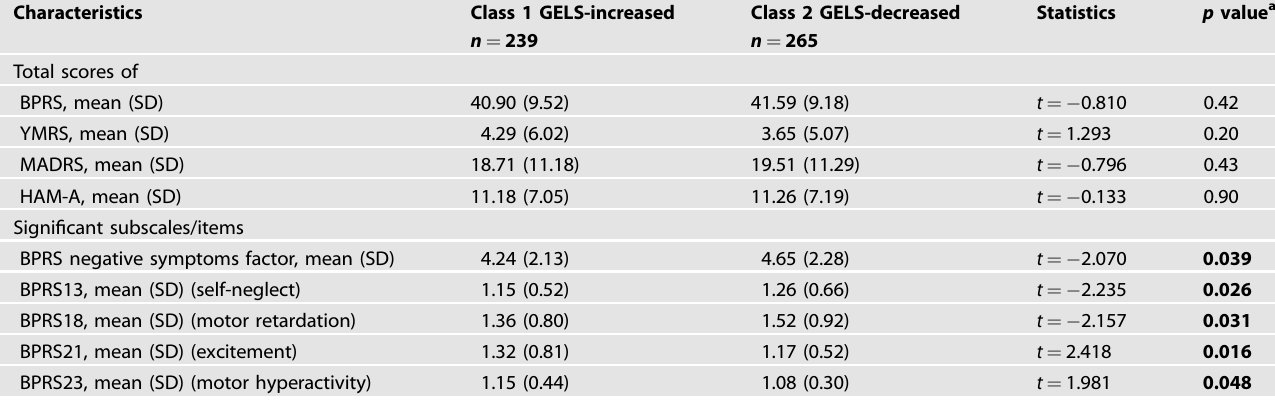
Table 3. Clinical characteristics between latent classes ( n =